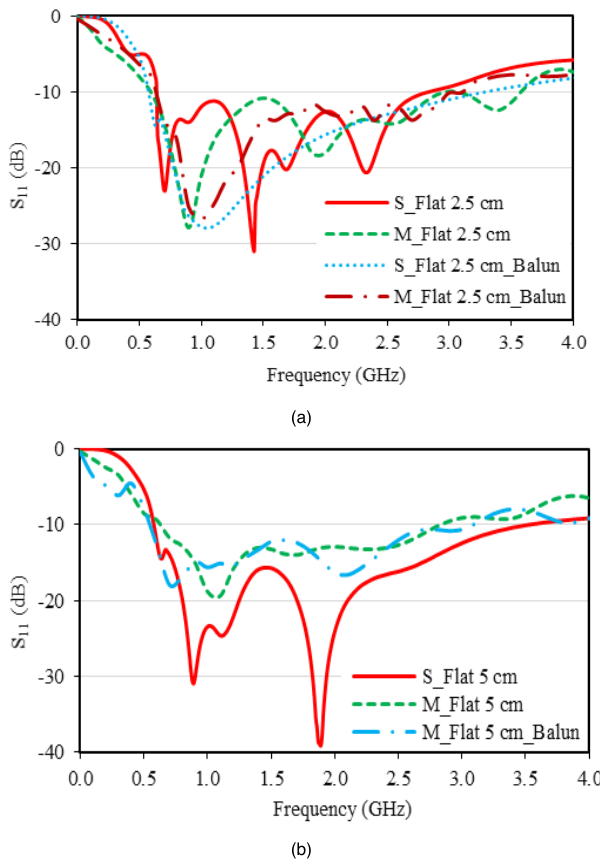
FIGURE 4. S 11 of flat flexible antenna implanted in muscle phantom at (a) 2.5 cm and (b) 5 cm depths based on simulation (S) and measurement (M)